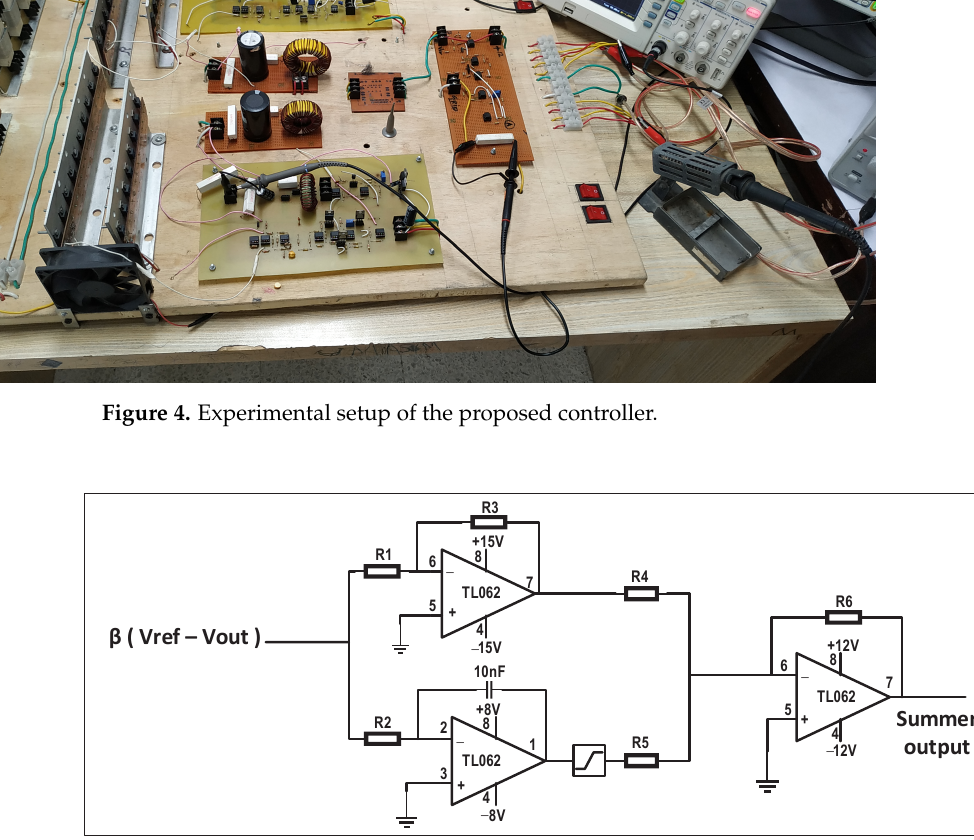
Figure 5. Electronic circuit used for PI